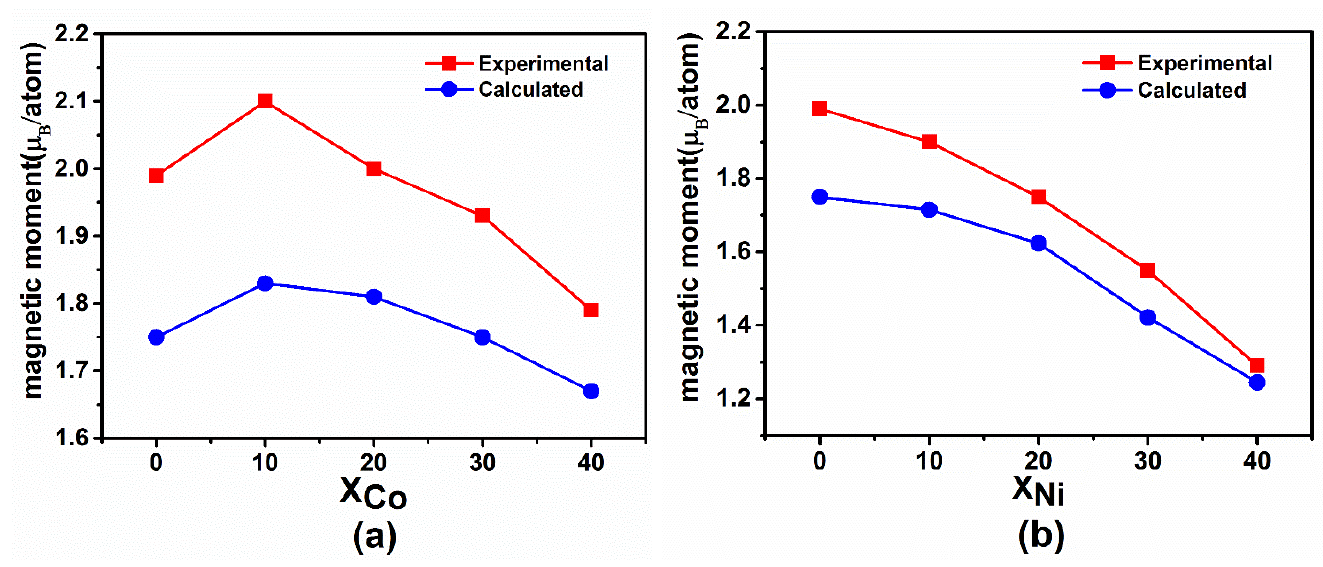
Figure 1. Comparison of magnetic moments of ( a ) Fe 80 − x Co x B 20 and ( b ) Fe 80 − x Ni x B 20 (x = 0, 10, 20, 30, and 40 at.%) amorphous alloys obtained via experiments and calculations.